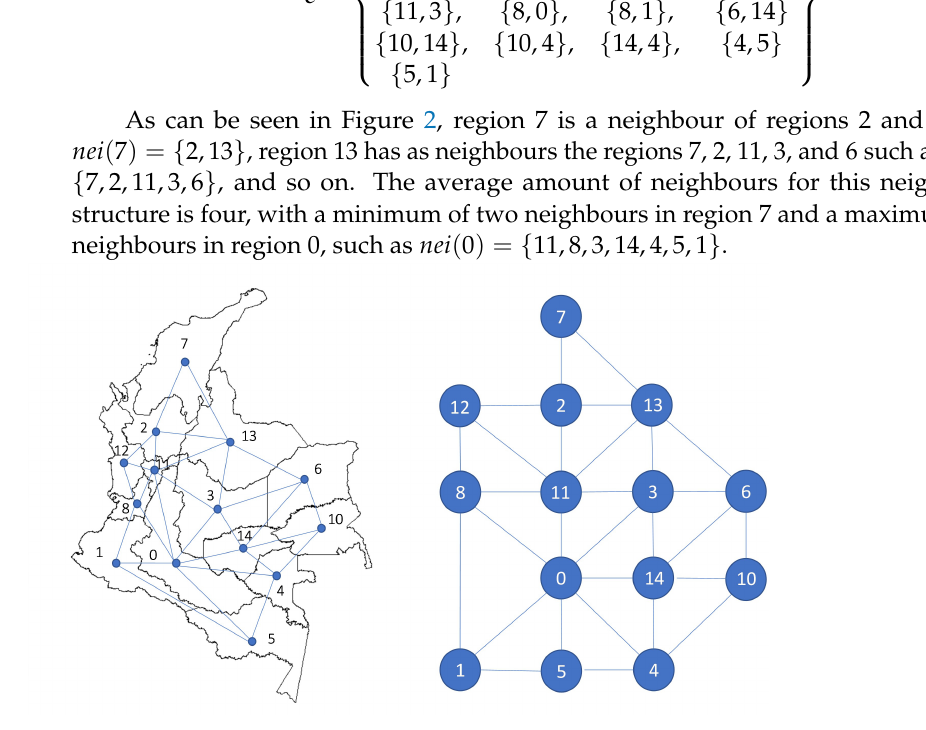
Figure 2. Neighbourhood structure relationship applied to Colombia. Regions form an irregular lattice. The left column shows the conditional dependence between the connected regions while the right column translates it to nodes.